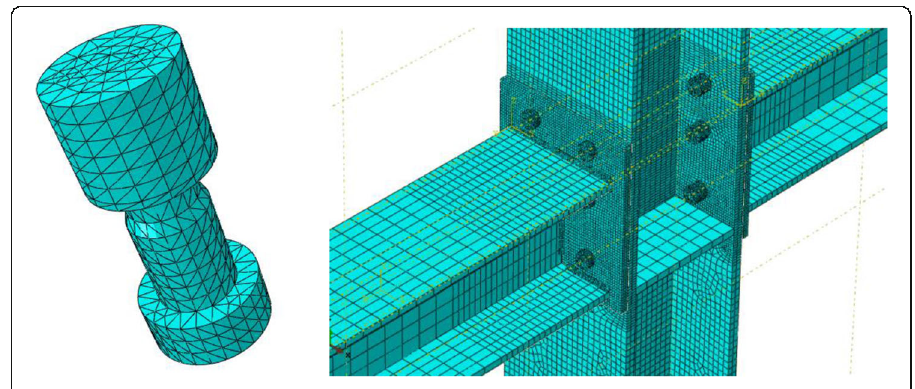
Fig. 11 Bolt and nut meshing/model meshing